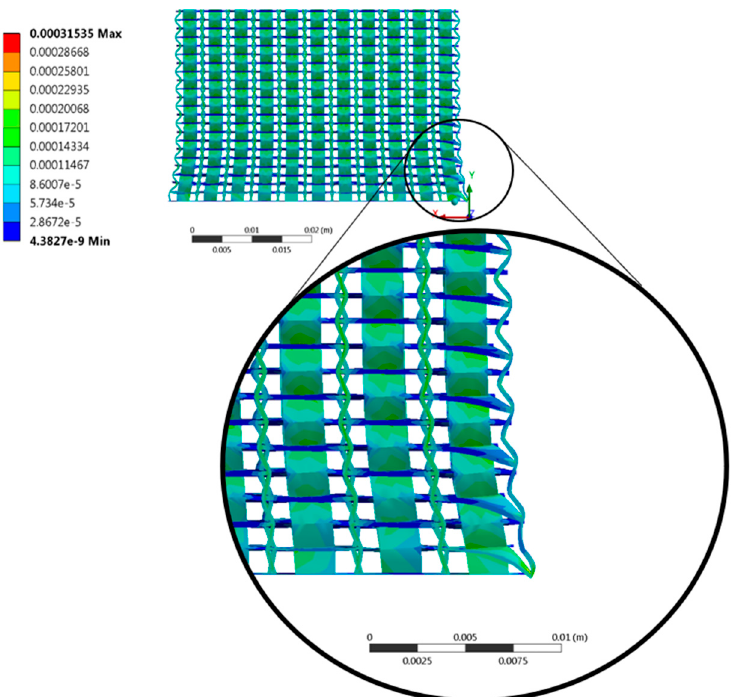
Figure 18. Magnified view of strain distribution in AUX lattice at 1000× deformation factor.